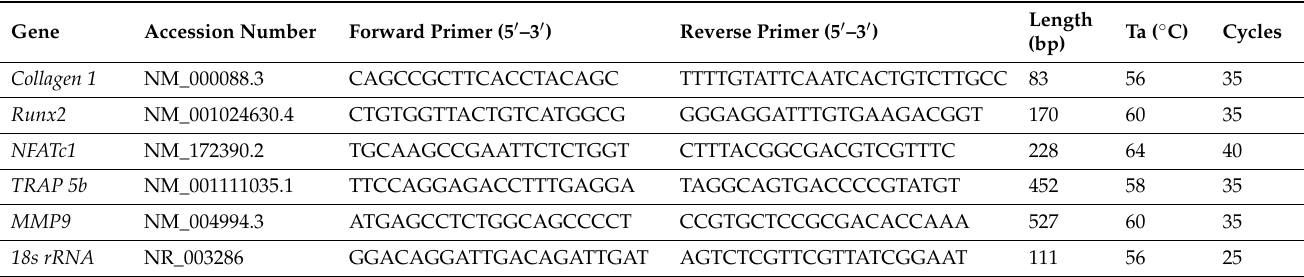
Table 1. Primer sequences and PCR conditions for target